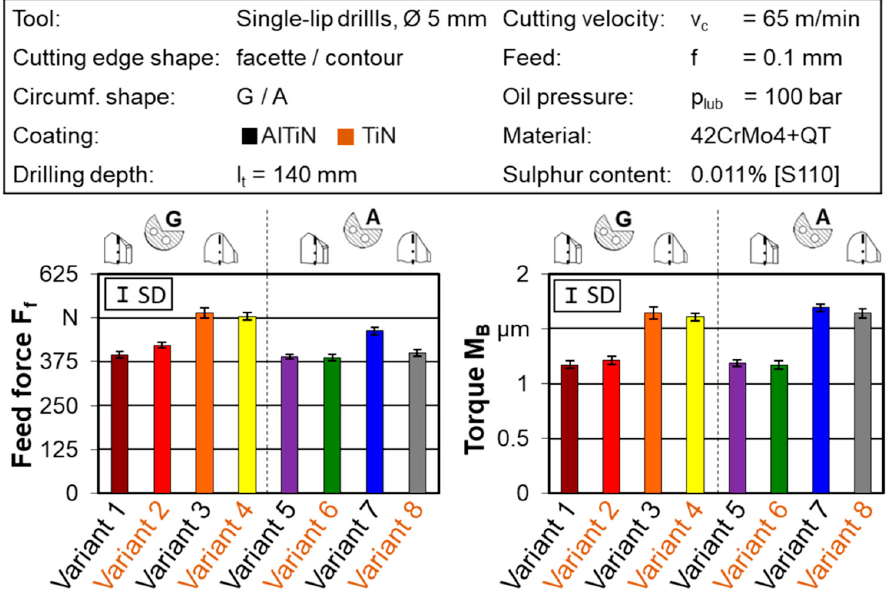
Figure 5. Measured feed force and torque using different drill variants [22].